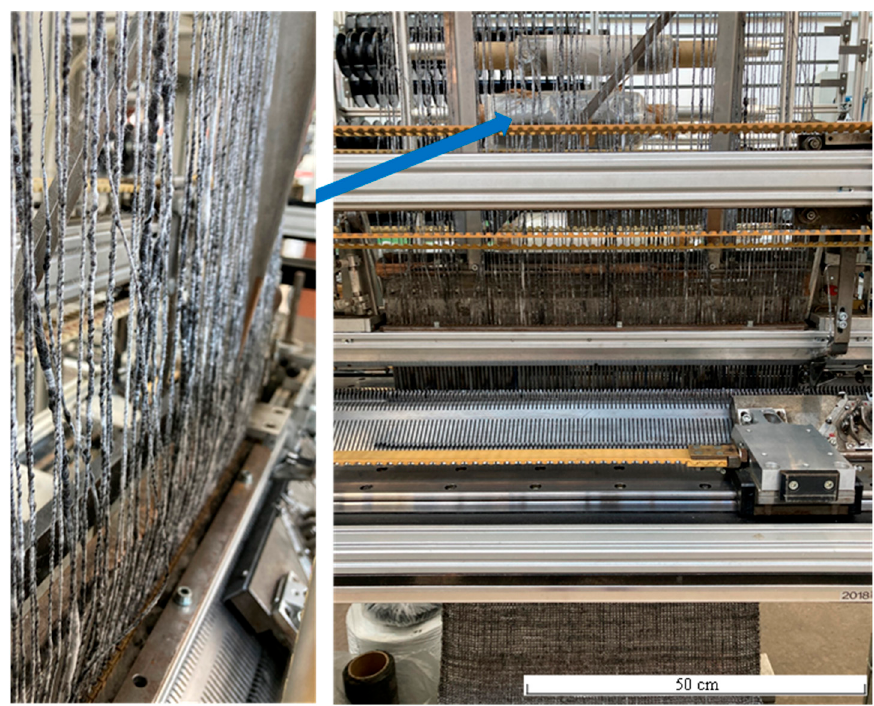
Figure 1. Modified biaxial weft knitting machine (gauge E5, working width 500 mm), with the warp yarn feed from the top of the machine (left picture, position shown by blue arrow).